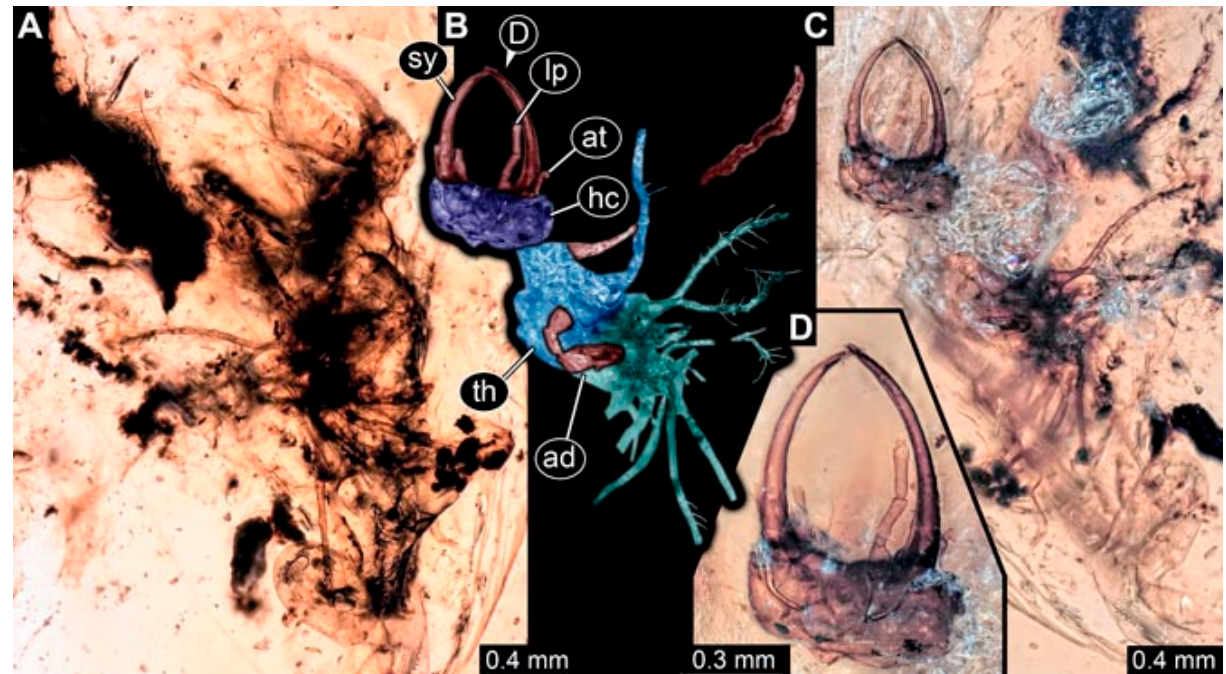
Figure 22. Specimen 4843 (PED 0455); Myanmar amber. ( A ) Ventral view. ( B ) Dorsal view, colour-marked. ( C ) Dorsal view. ( D ) Close-up of head capsule in dorsal view. Abbreviations: ad = abdomen; at = antenna; hc = head capsule; lp = labial palp; sy = stylet; th = thorax.